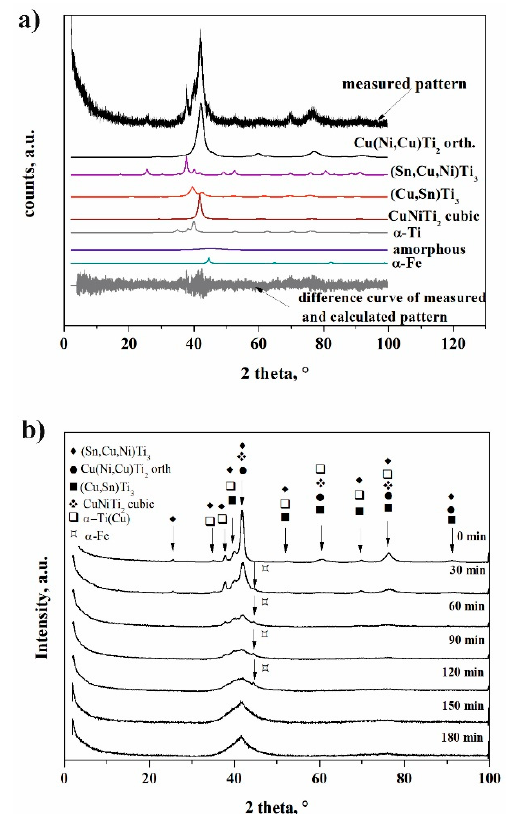
Figure 6. X-ray diffraction patterns of powder ( a ) after 30 min of milling and ( b ) powders with different milling time.